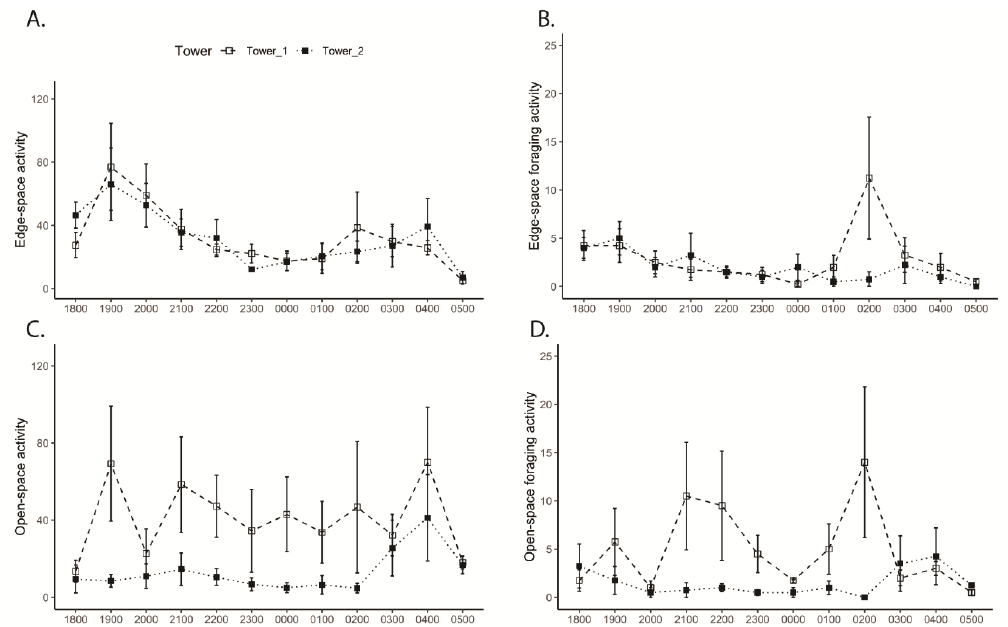
Figure 5. Bat activity and foraging intensity by guild and tower recorded from 50 m radio towers over four nights. Average ( ± standard error) bat activity ( A , C ) and foraging activity ( B , D ) recorded from Tower 1 (dashed line) and Tower 2 (dotted line).